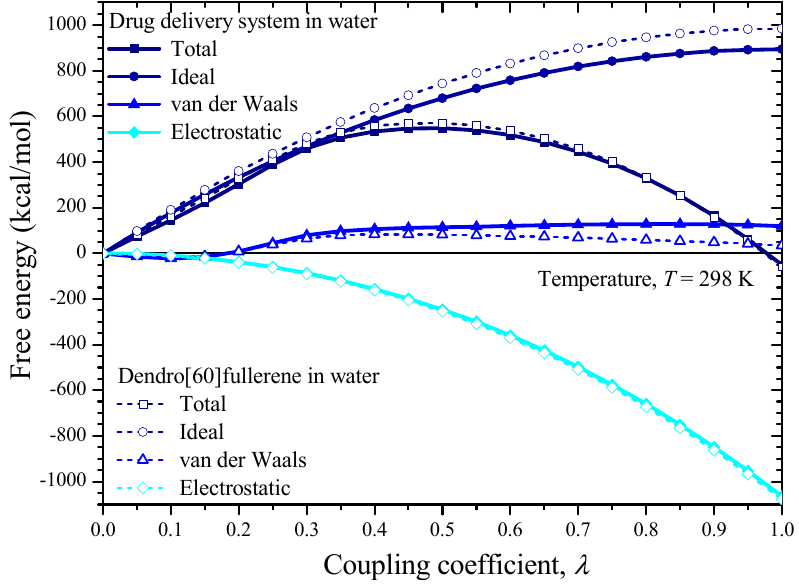
Figure 10. The free energies of the dendro[60]fullerene/molnupiravir drug delivery system and the dendro[60]fullerene in water versus the value of the coupling coefficient.